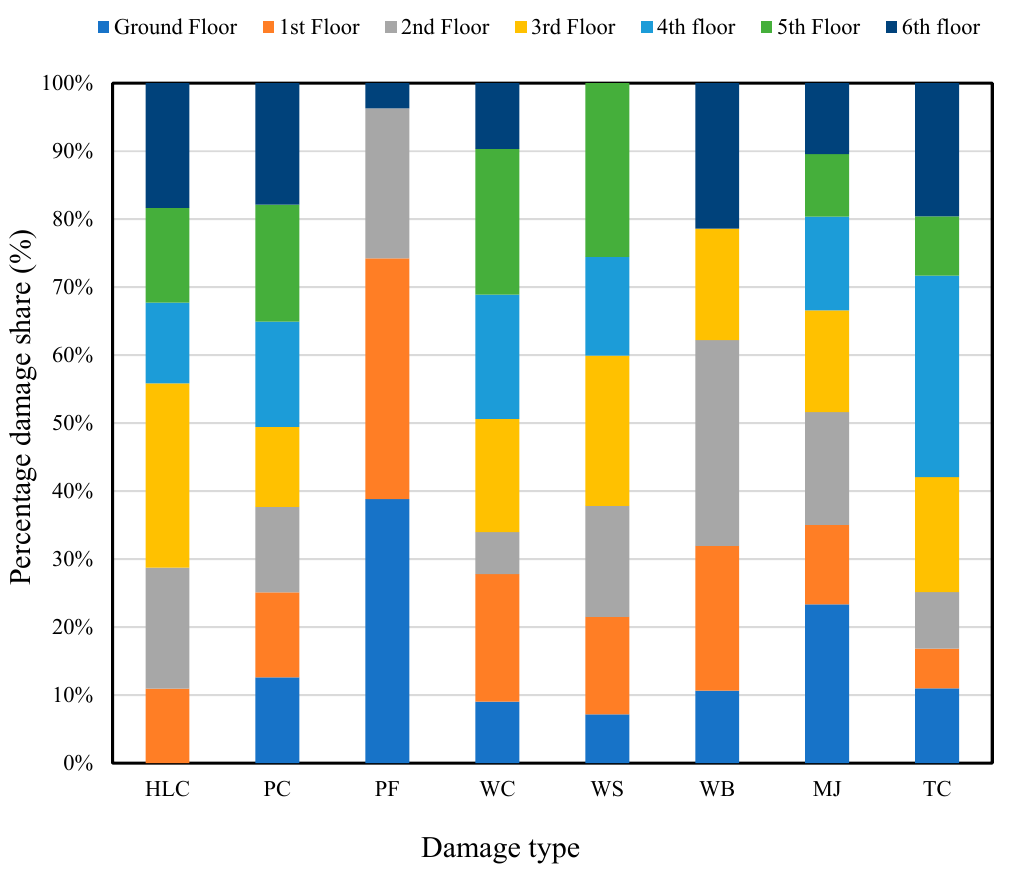
Figure 7. Storey-wise distribution of damage in the case study Figure 7. Storey ‐ wise distribution of damage in the case study building.